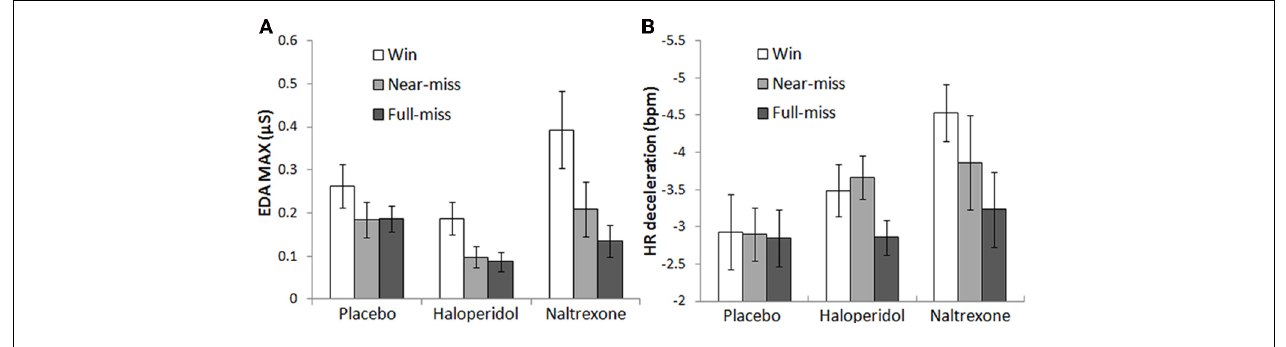
FIGURE 5 | Psychophysiological responses on the slot machine task: (A) Naltrexone significantly increased post-outcome EDA following wins compared to both non-win outcomes (collapsing across choice